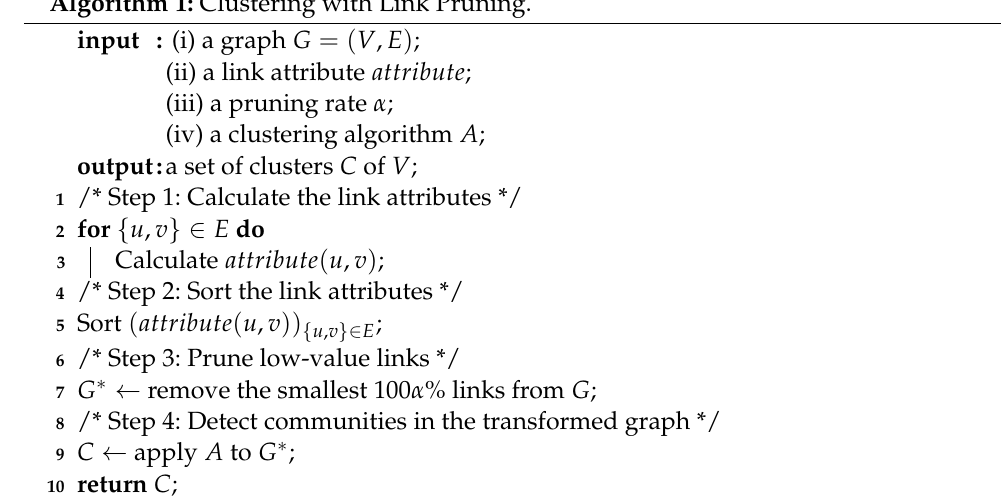
Algorithm 1: Clustering with Link